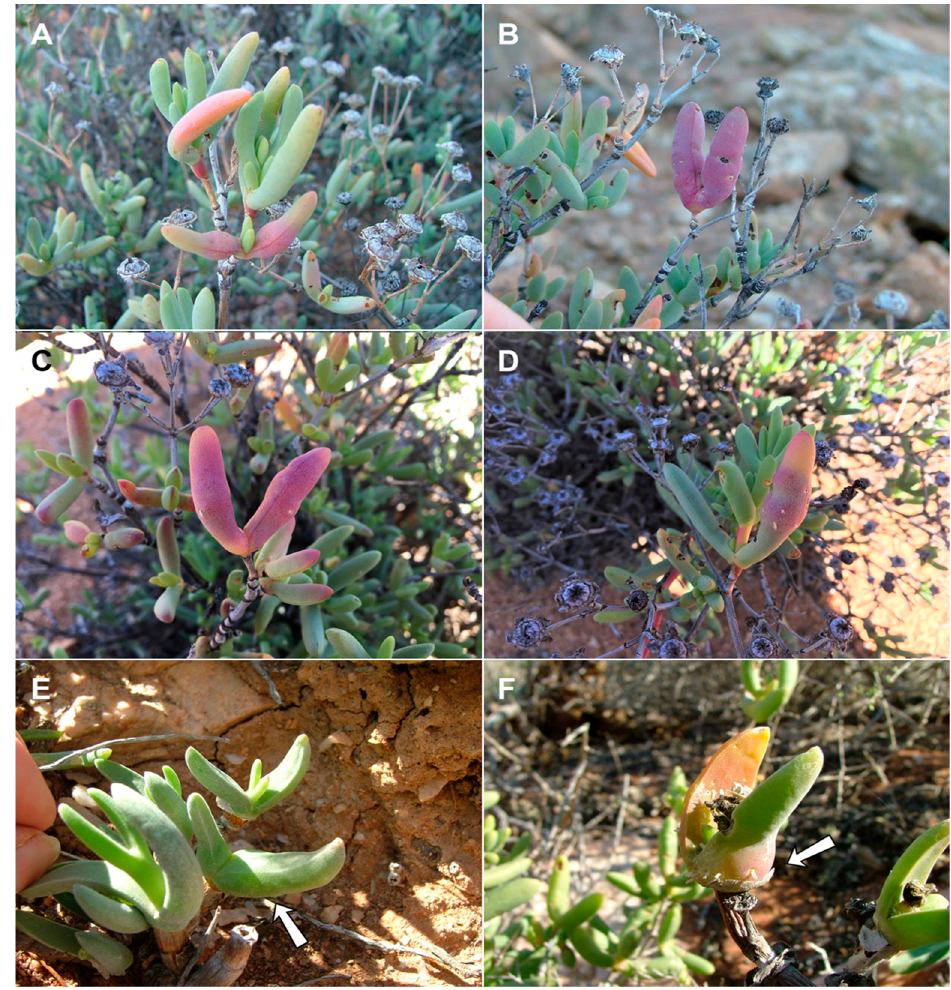
Figure 15. Ruschiola galls. ( A , B ) R. leipoldtiae on Leipoldtia laxa . ( C , D ) R. leipoldtiae on Leipoldtia scultzei . ( E , F ) R. celebrata on Mitrophyllum mitratum . Arrows: galled part of leaf. Adult : Head : Antennal flagellomeres 11–13 in female ( n = 26), 11–12 in male ( n =